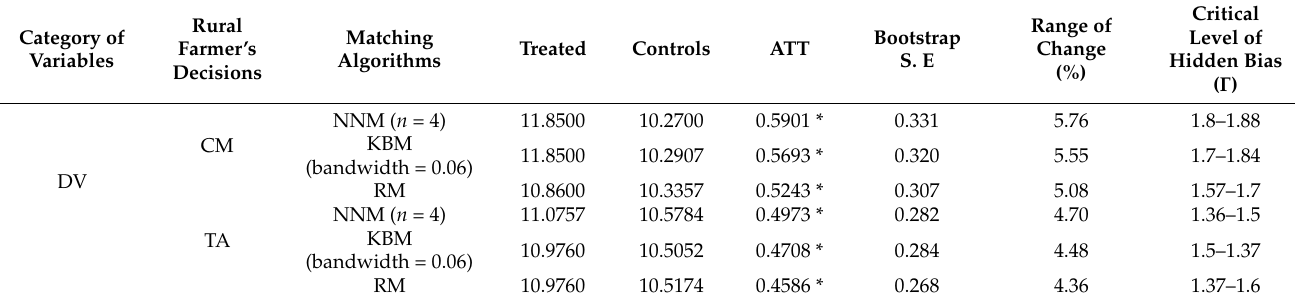
Table 9. ATT and sensitivity assessment findings of low-income